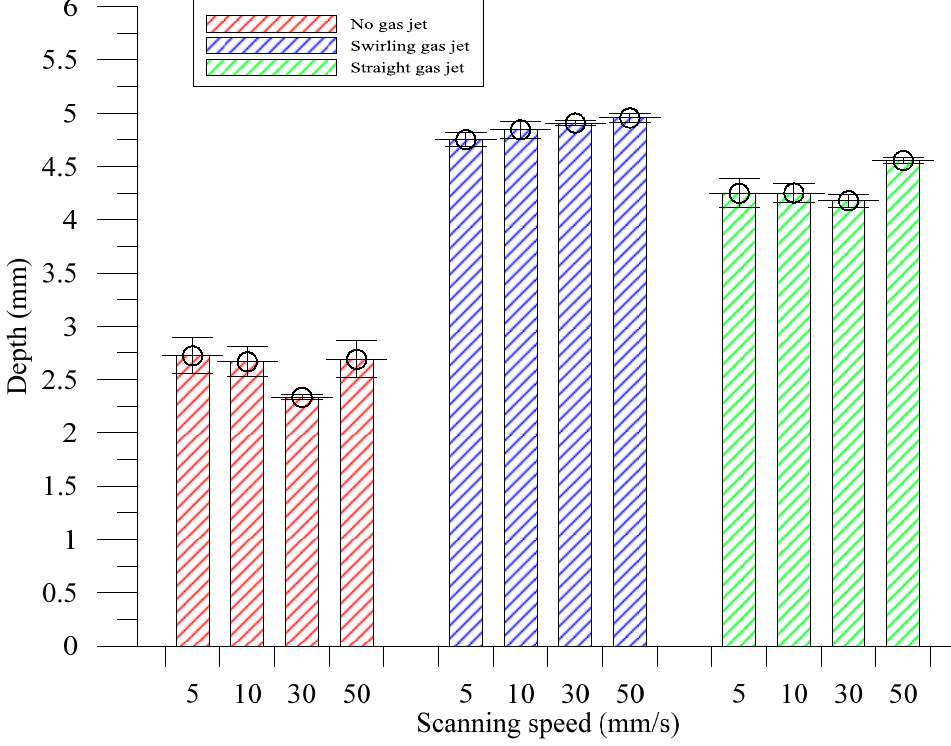
Figure 11. Laser trepanning depth with different gas jet configurations (no gas jet, swirling gas jet, and straight gas jet) at different laser scanning speeds.